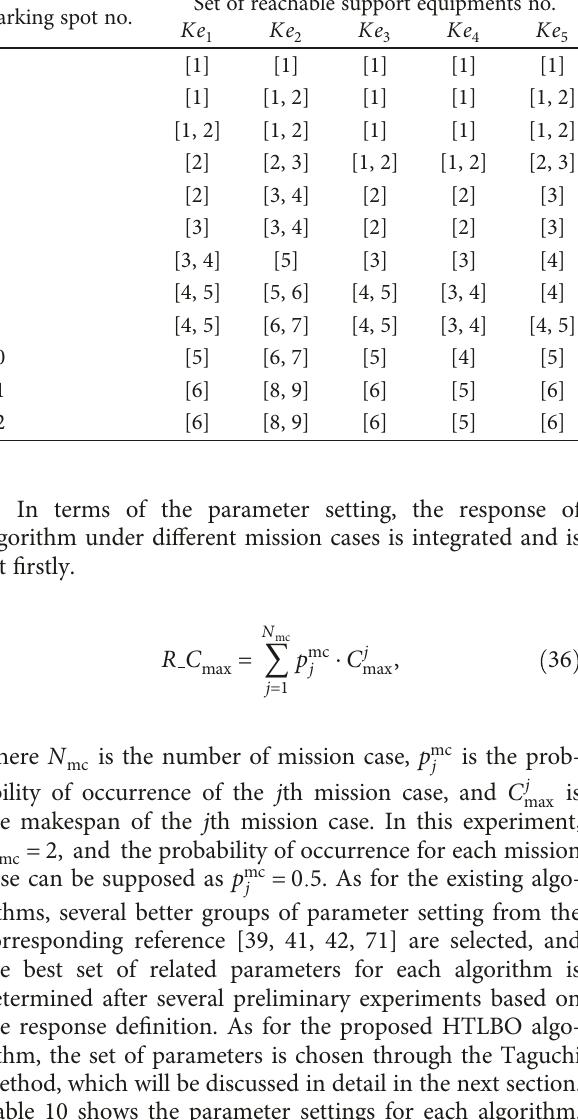
Table 11. The best results demonstrate the capacity of searching for the optimal solution, and the solution quality and the robustness of the algorithm can be evaluated by the average result and standard deviation.